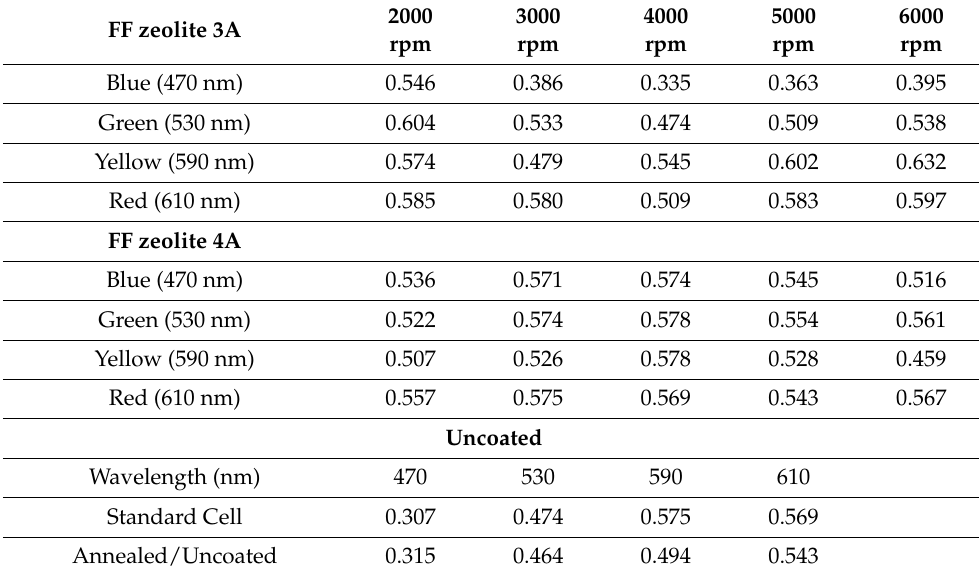
Table 3. Fill factor vs. deposition parameters for zeolite-coated and control solar cells considering incoming radiation